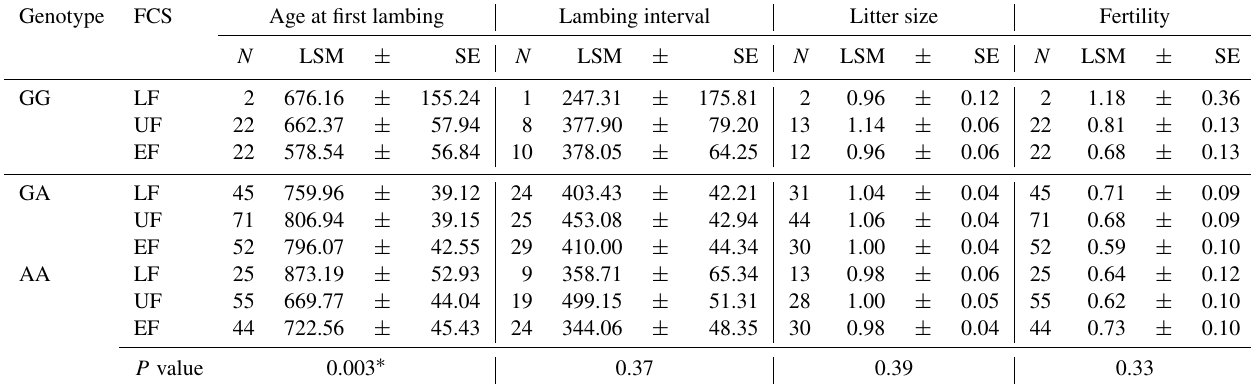
Table 6. Effect of the AA-NAT SNP on reproductive traits in Egyptian sheep breeds in their first conception season. Where N is the number of observed genotypes; LSM represents least-square mean; SE represents standard error; LF represents late favorable season; UF represents unfavorable season; EF represents early favorable